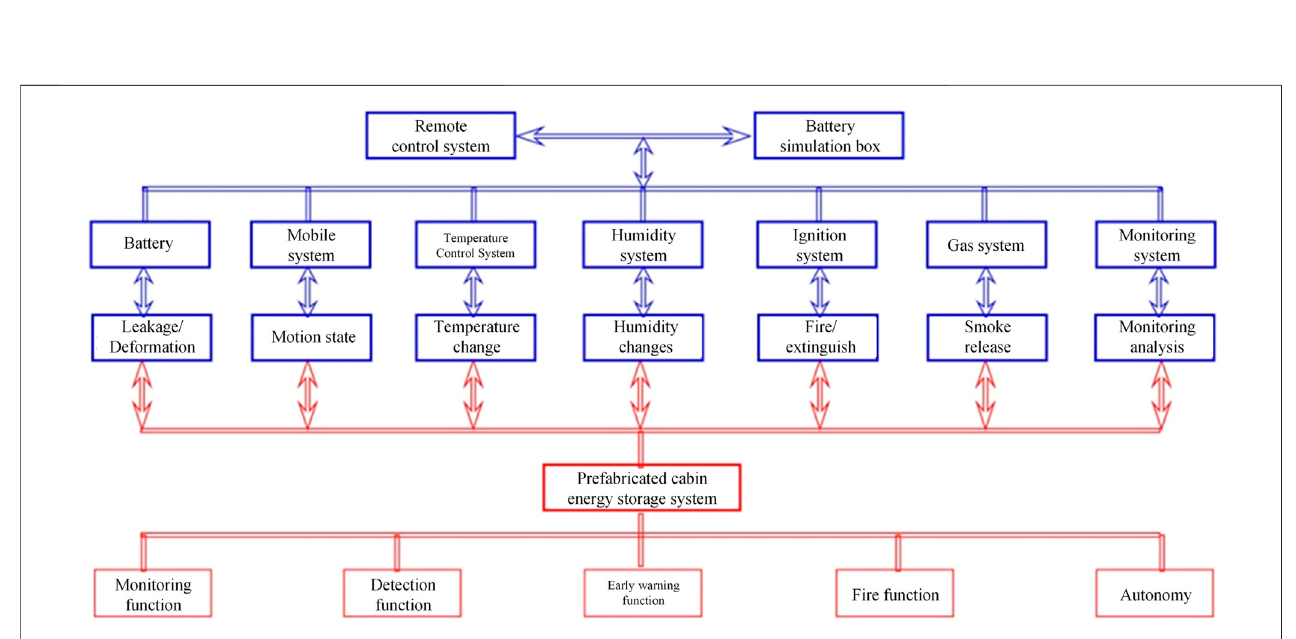
FIGURE 11 | Inspection test scheme for cabin-type energy storage system.